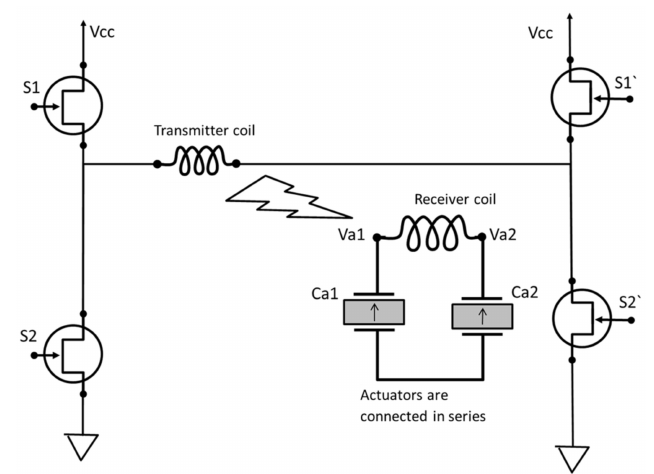
Figure 7. Schematic of the wireless piezoelectric inertia-type motor driving using class-D amplifier topology. The two multilayer actuators in the stator of the motor are connected in series with the receiver